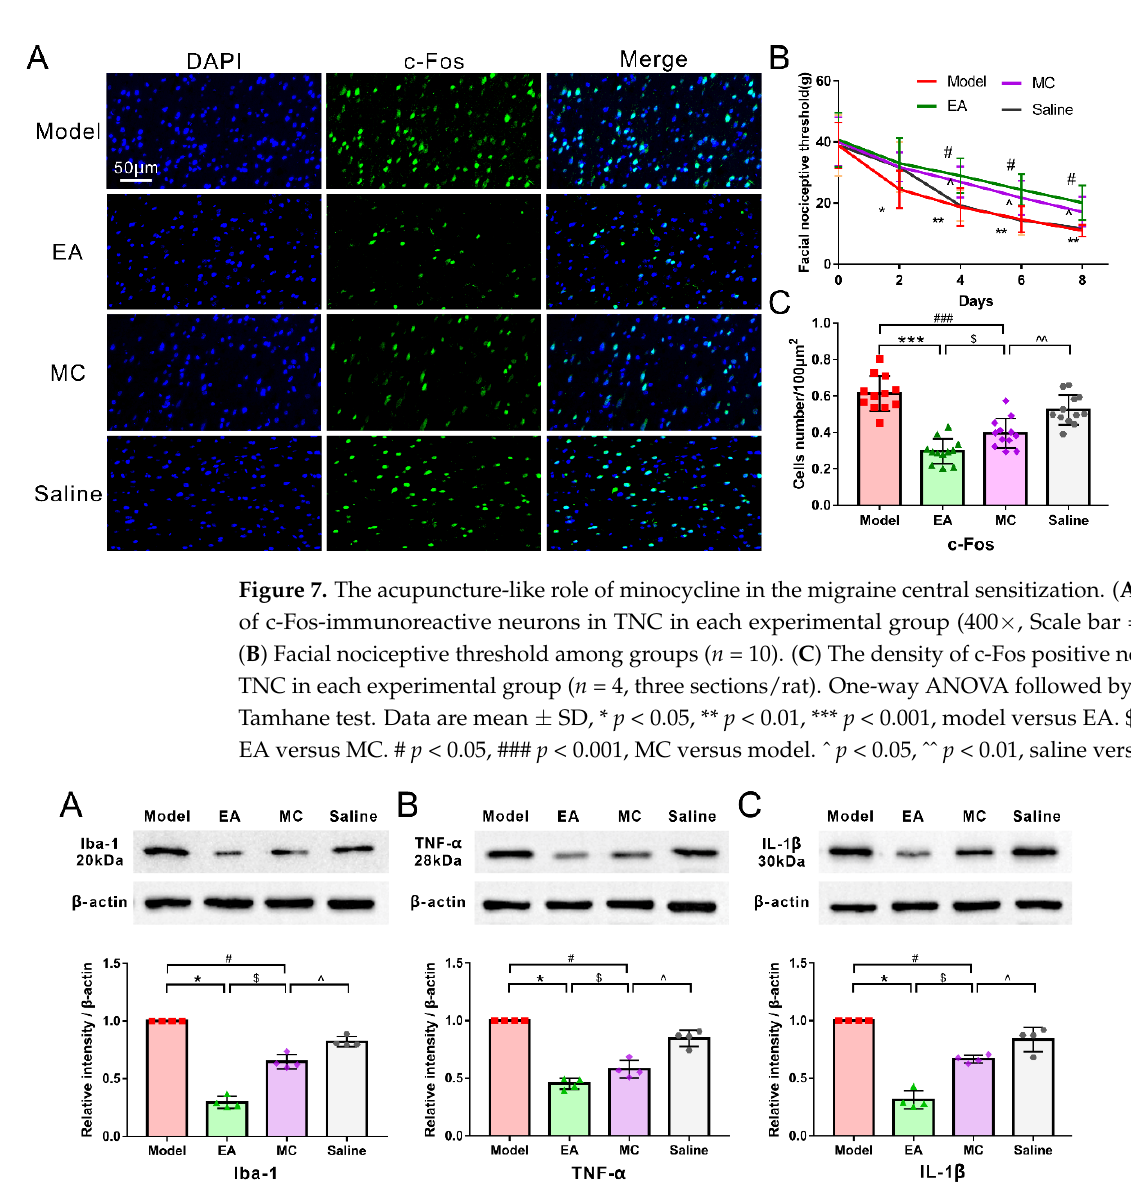
Figure 8. The acupuncture-like effect of minocycline on microglia activation in migraine rat. West- ern blot analysis and band density quantification of Iba-1 ( A) , IL-1 β ( B ) and TNF- α ( C ) ( n = 4). Mann– Whitney nonparametric test. Data are mean ± SD. * p < 0.05, model versus EA. $ p < 0.05, EA versus MC. # p < 0.05, MC versus model. ^ p < 0.05, saline versus MC.